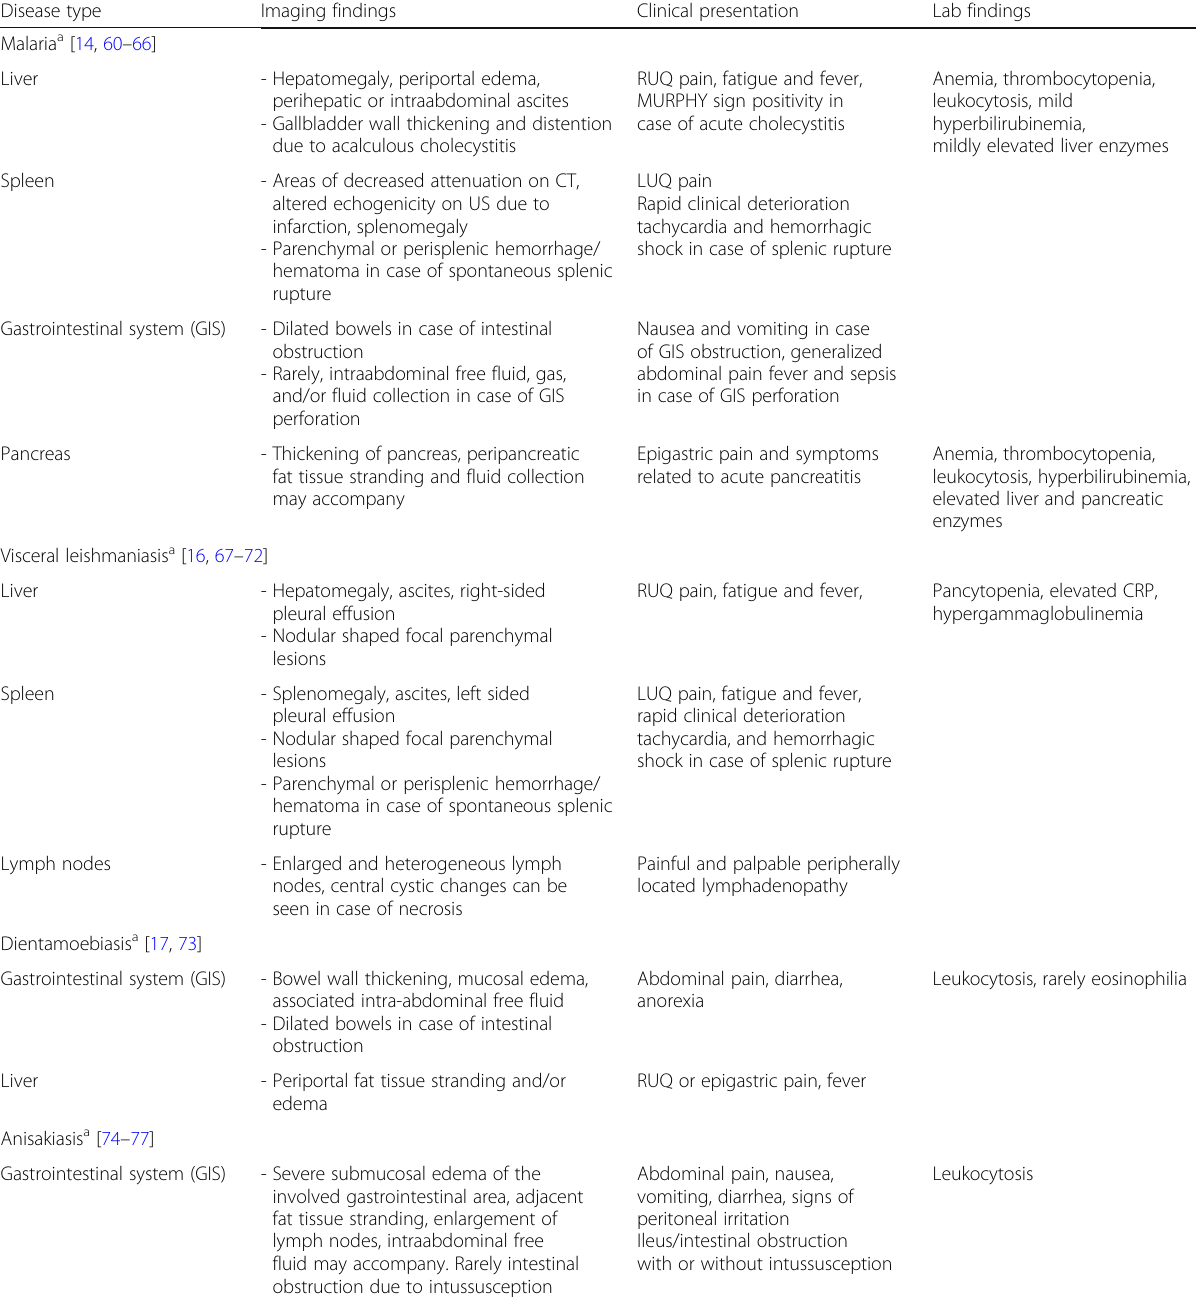
Table 2 Parasitosis and affected abdominal organs. Associated radiological, clinical, and laboratory findings (Continued) Disease